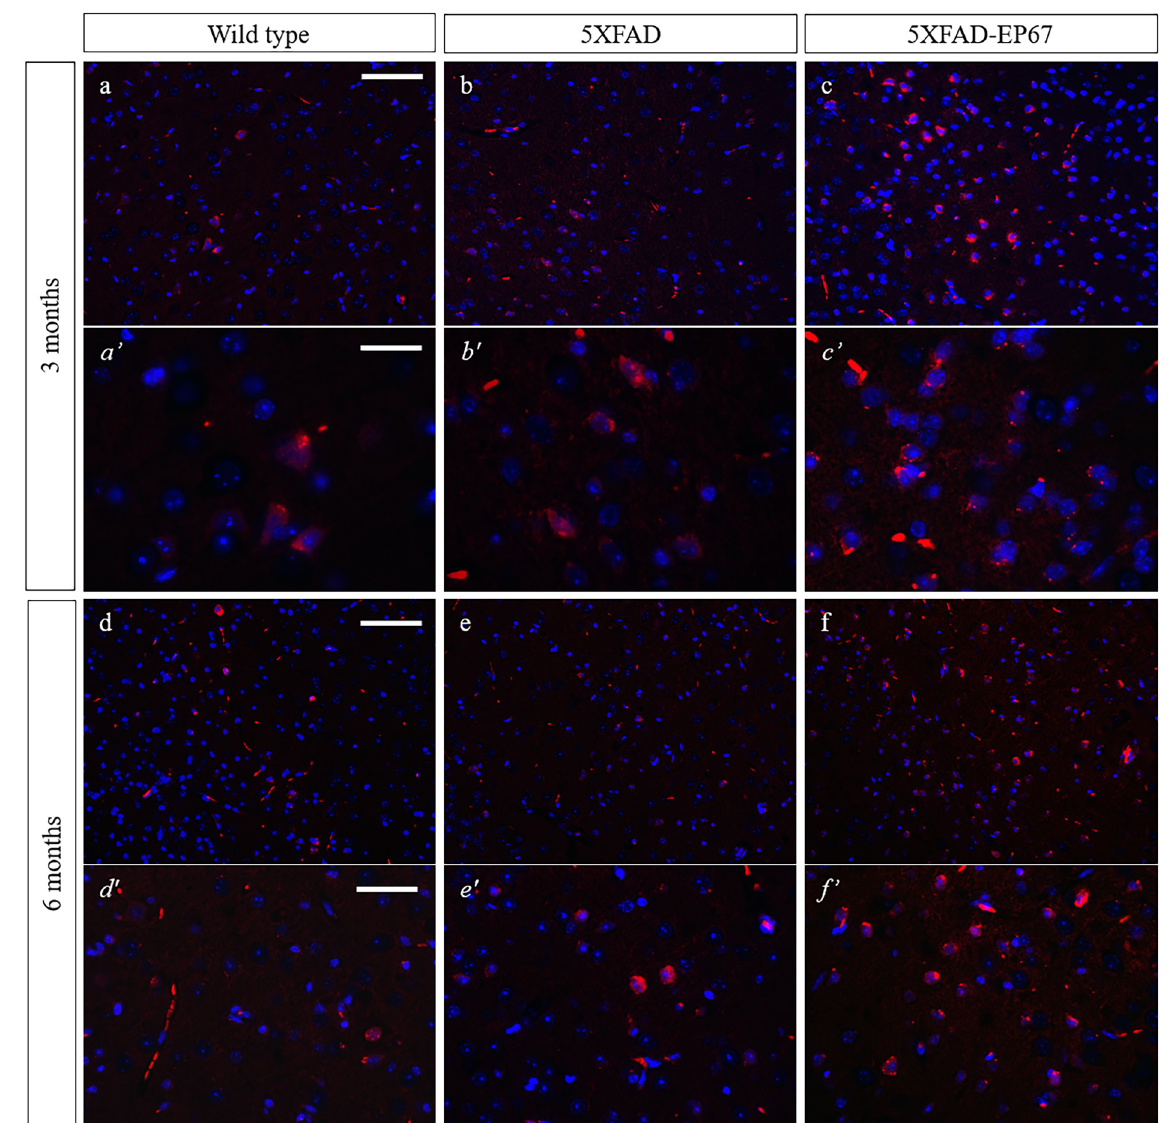
Fig 11. F4/80 expression. Representative sagittal cortex sections from 3 and 6 month old wild type (a, a’ & d, d’ ), 5XFAD (b, b’ & e, e’ ) and 5XFAD EP67 treated (c, c’ & f, f’ ) mice sections were co-stained with an antibody against F4/80 (-red- excitation λ : 358 emission λ :461) and DAPI nuclear staining (-blue- excitation λ : 555 emission λ :580). Scale bars: a-c & d-f 150 μ m, a’- c’ 75 μ m and d’-f’ 48 μ m.